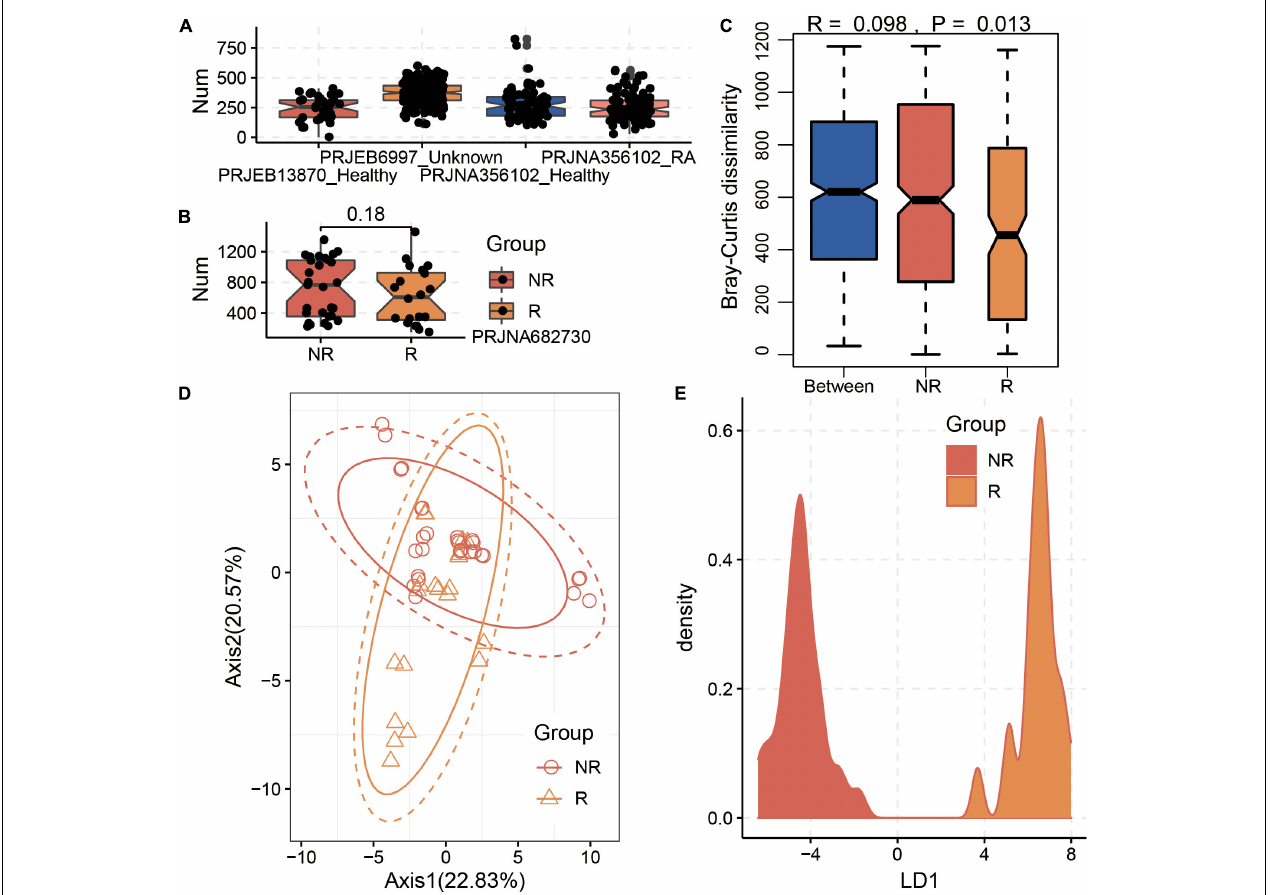
FIGURE 2 | Significant differences in the composition of genes involved in methotrexate (MTX) metabolism between the R and NR groups. (A) Gut microbiota harbors various genes involved in MTX metabolism in healthy individuals and RA patients. (B) Distribution of genes involved in MTX metabolism in the gut microbiota in the R and NR groups based on the training data of the BioProject PRJNA682730. A significant difference existed between the R and NR groups based on (C) Bray–Curtis dissimilarity and (D) Principal component analysis (PCA) analysis. (E) Linear discriminant analysis (LDA) analysis of the sample distribution showed a distinct separation between the R and NR